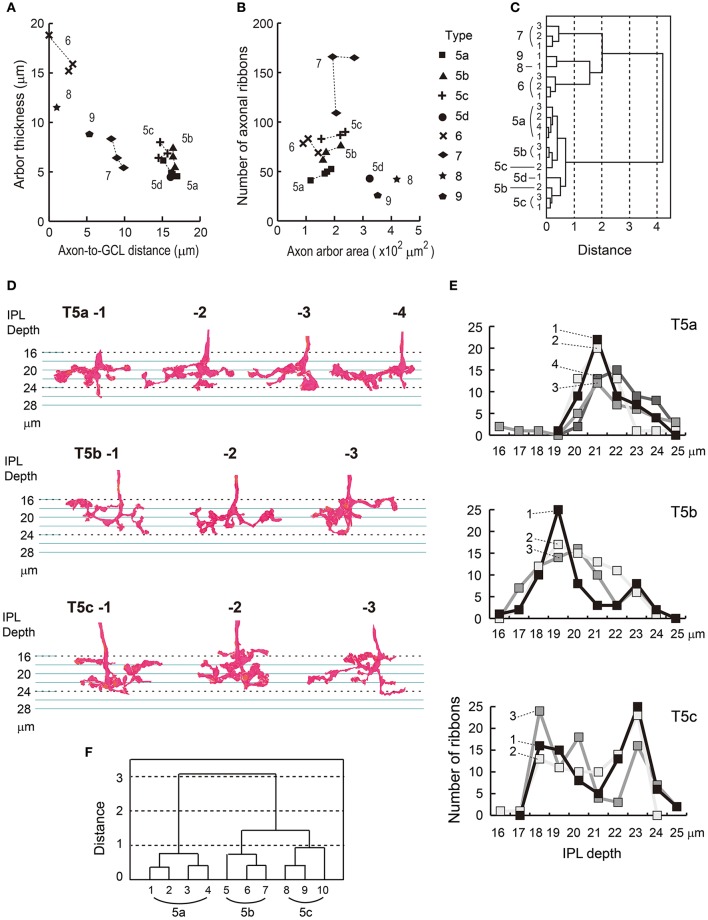
Cluster analysis of eight types of ON bipolar cells and a reexamination of type 5a, 5b, and 5c cells. (A) The scatter plot shows thickness of an axon arbor vs. the distance between the axonal tip and the ganglion cell layer. (B) The scatter plot shows the top-view area of an axon arbor vs. the number of synaptic ribbons. (C) A dendrogram of cluster analysis (Ward's method) of 19 ON bipolar cells using the four variables plotted in (A,B). Two groups of cells (types 5b and 5c) are intermingled, but other cells are separated into six distinct clusters (types 5a, 5d, 6, 7, 8, and 9). (D) Side-view profiles of axon terminal arbors of type 5a, 5b, and 5c cells. (E) The vertical distribution of the number of synaptic ribbons per μm along the axon. (F) A dendrogram of cluster analysis (Ward's method) of 10 type 5 bipolar cells, using the distribution patterns of synaptic ribbons in (E).